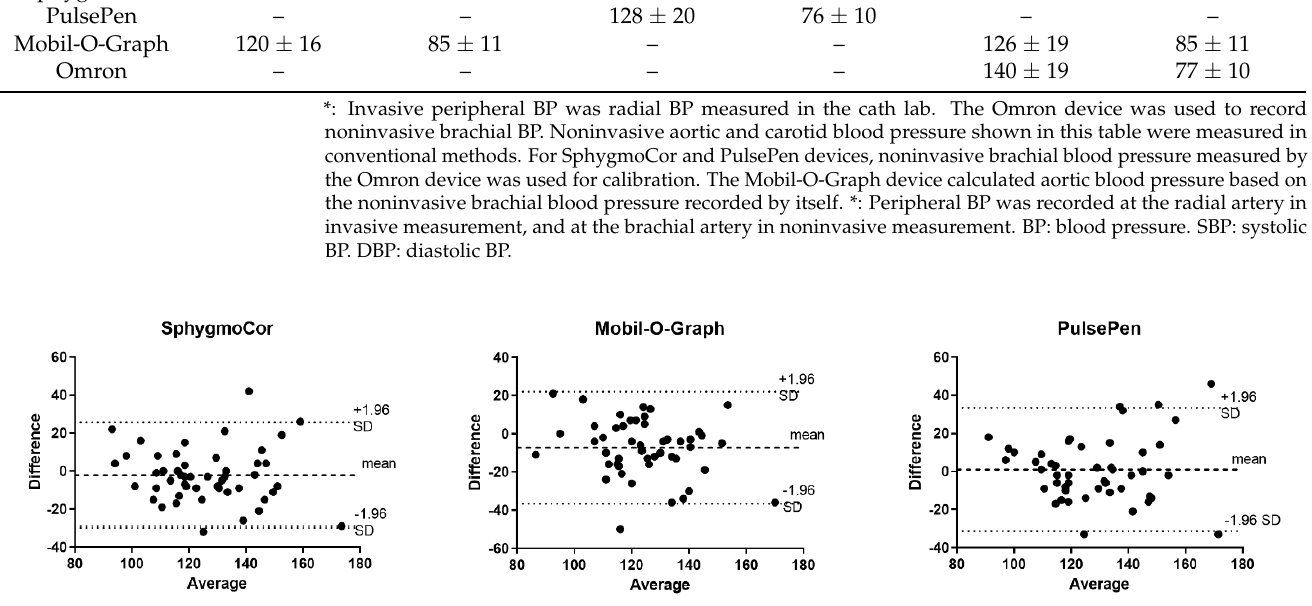
Figure 2. Bland-Altman plots. Bland-Altman plots were used to compare the invasive measure-ment and each corresponding noninvasive SBP measurement determined by standard protocol, namely the brachial systolic/diastolic calibration method.